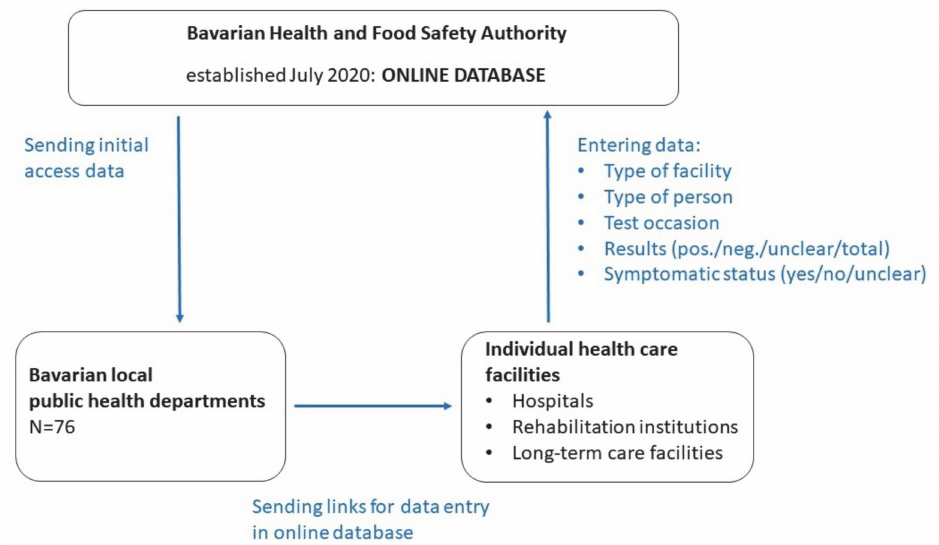
Figure 1. Overview of the interplay between the different actors and the data collection, processing, and sampling